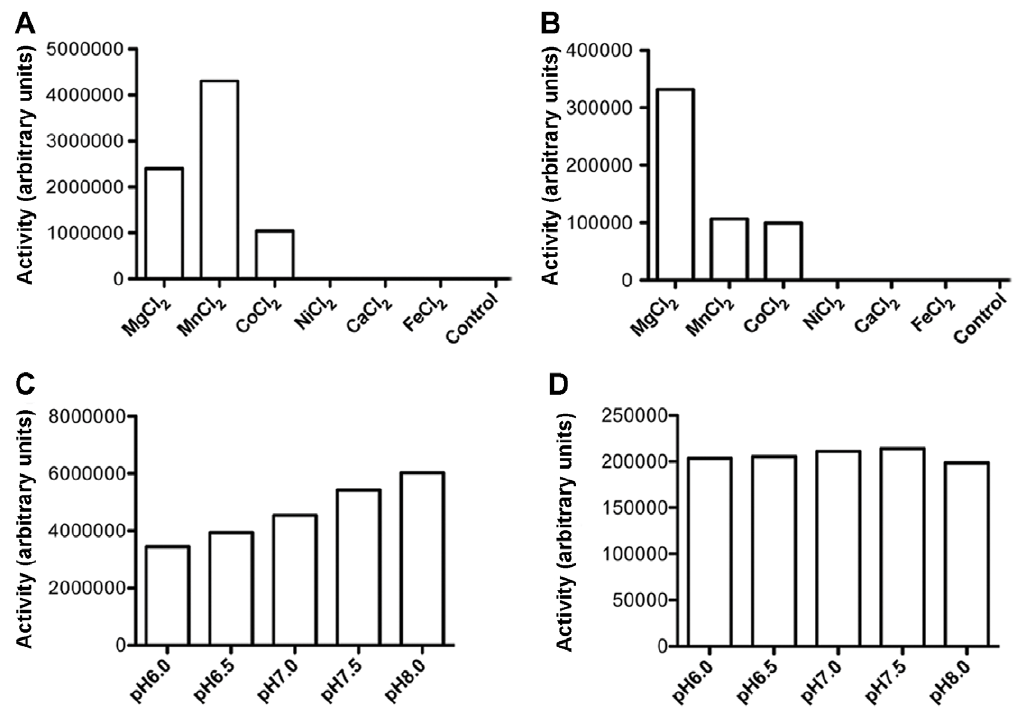
Figure 5. Effect of divalent metal ions and pH on DacA’s activities. (A and B) Effect of metal ions on c-di-AMP production catalyzed by DacA in the presence of 2 mM ATP (A) or 0.5 mM ADP (B). (C and D) Effect of pH on c-di-AMP production catalyzed by DacA in the presence of 2 mM ATP (C) or 0.5 mM ADP (D). Note that less ADP was used in the reactions compared with ATP, and thus the arbitrary units between reactions with ATP and ADP are not directly